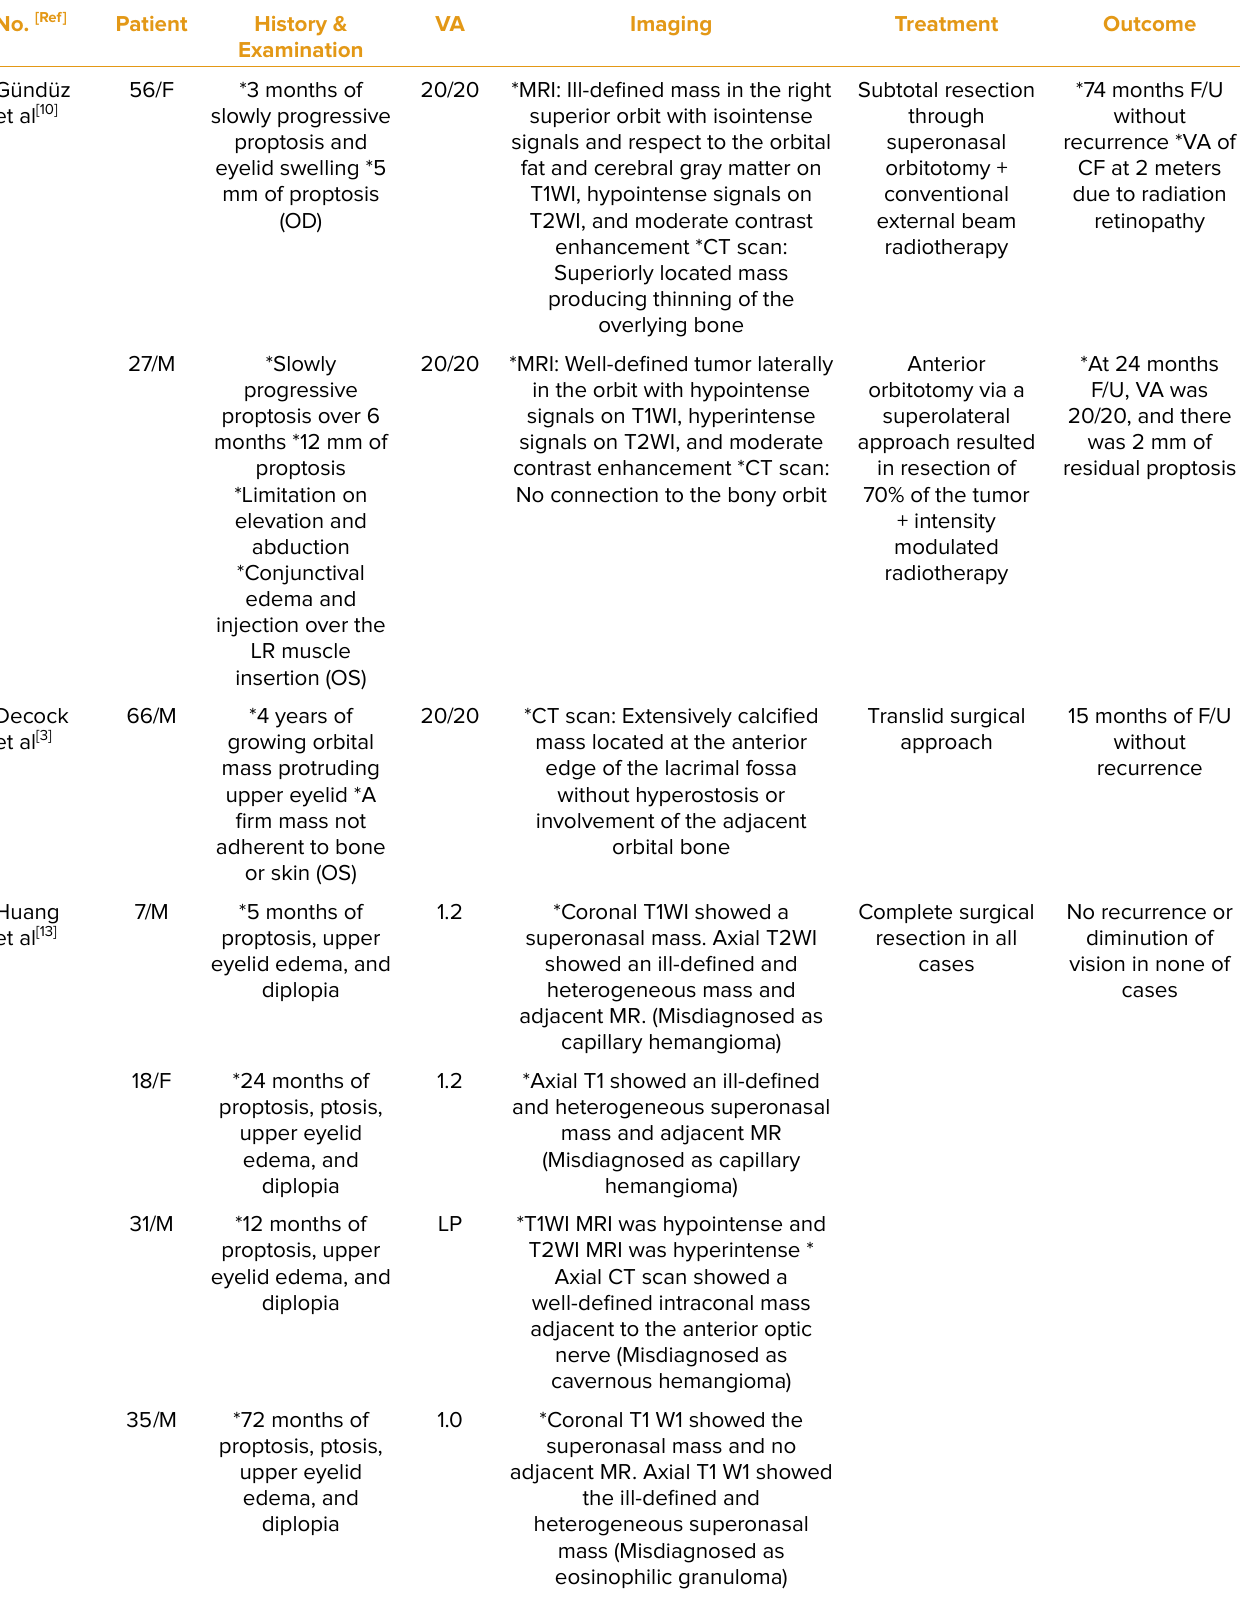
Table 1. Brief review on recent